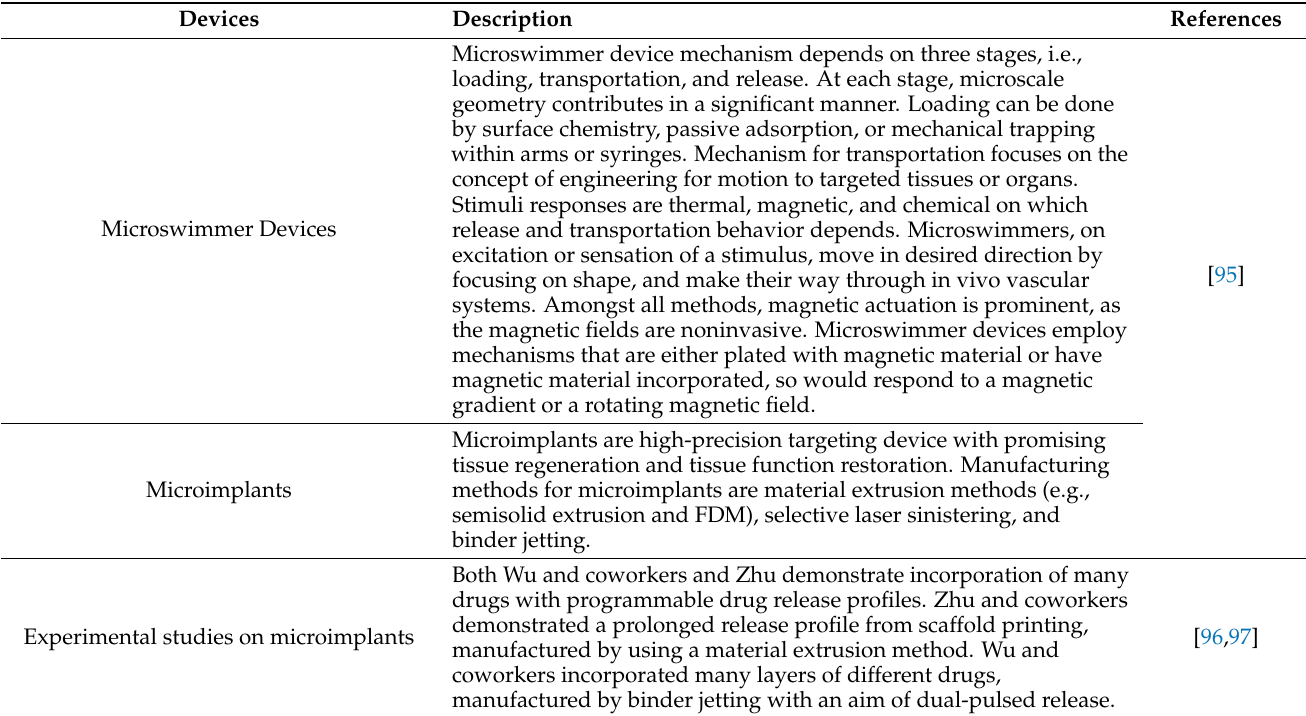
Table 4. Three-dimensionalprinting devices for targeted drug